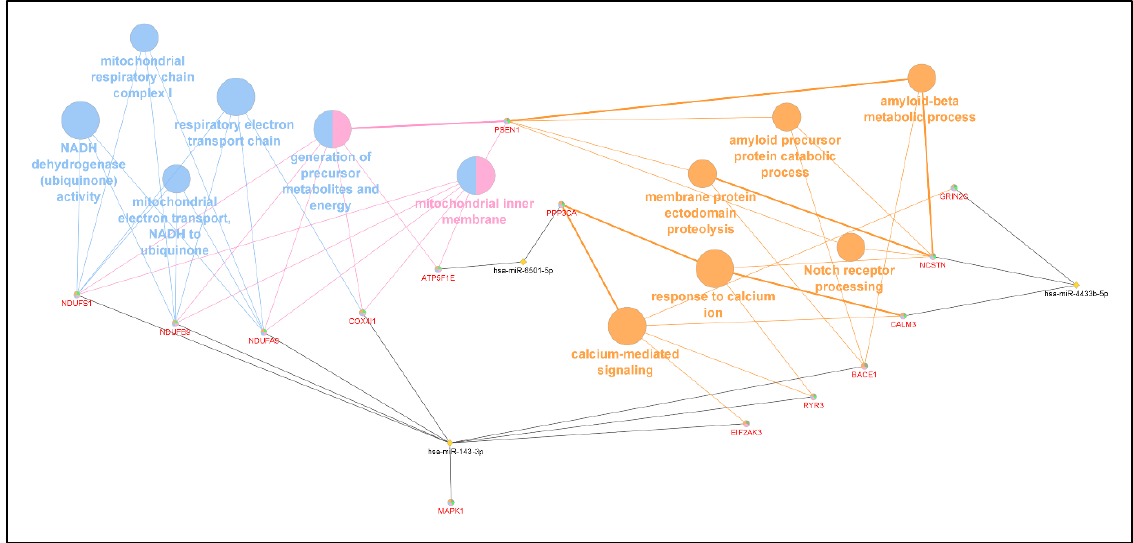
Figure 6. DEMi signatures and target genes enriched with GO terms. Enriched GO terms are indicated by the nodes, and the interactions between the terms and genes are represented using lines. The different colours of the nodes depict the different functional groups of the GO terms.